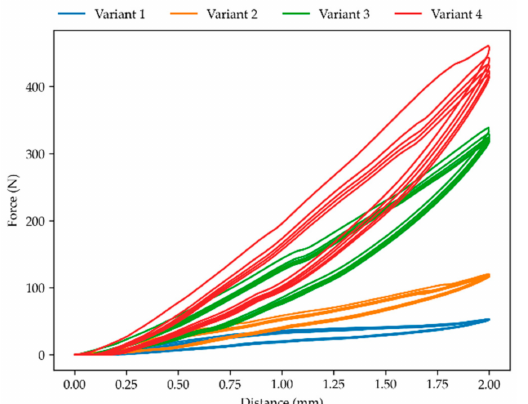
Figure 5. Force–distance relationship for variants 1 to 4 (Figure 1b–e), all with gaps of 0.3 mm and velocities of 10 mm/min. All variants show hysteresis, and the stiffer geometries show a decrease in peak force with repeated